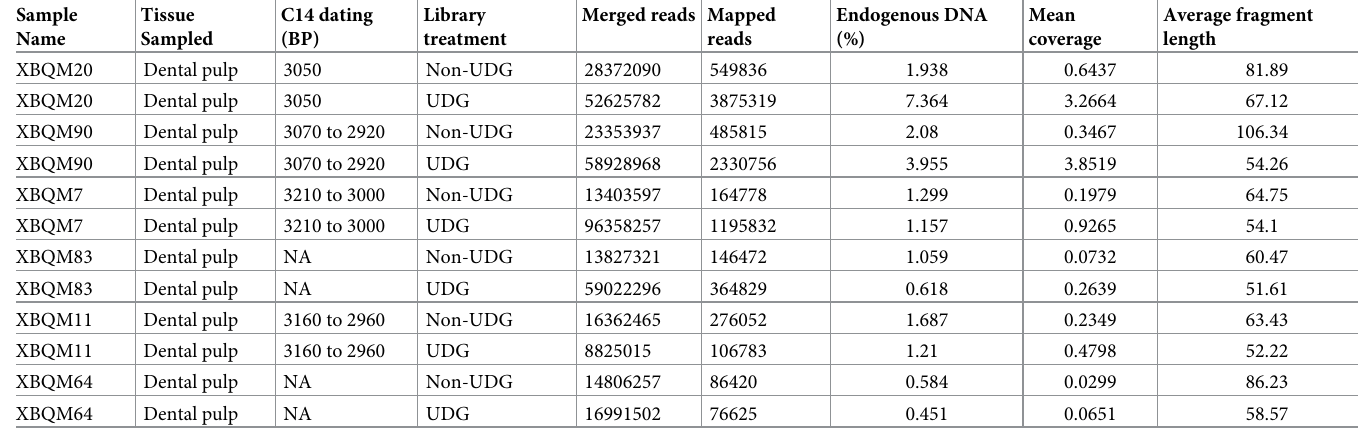
Table 1. Statistics of the Salmonella enterica Genome Reconstruction (including UDG library and Non-UDG library) of the XBQ individuals. Sample